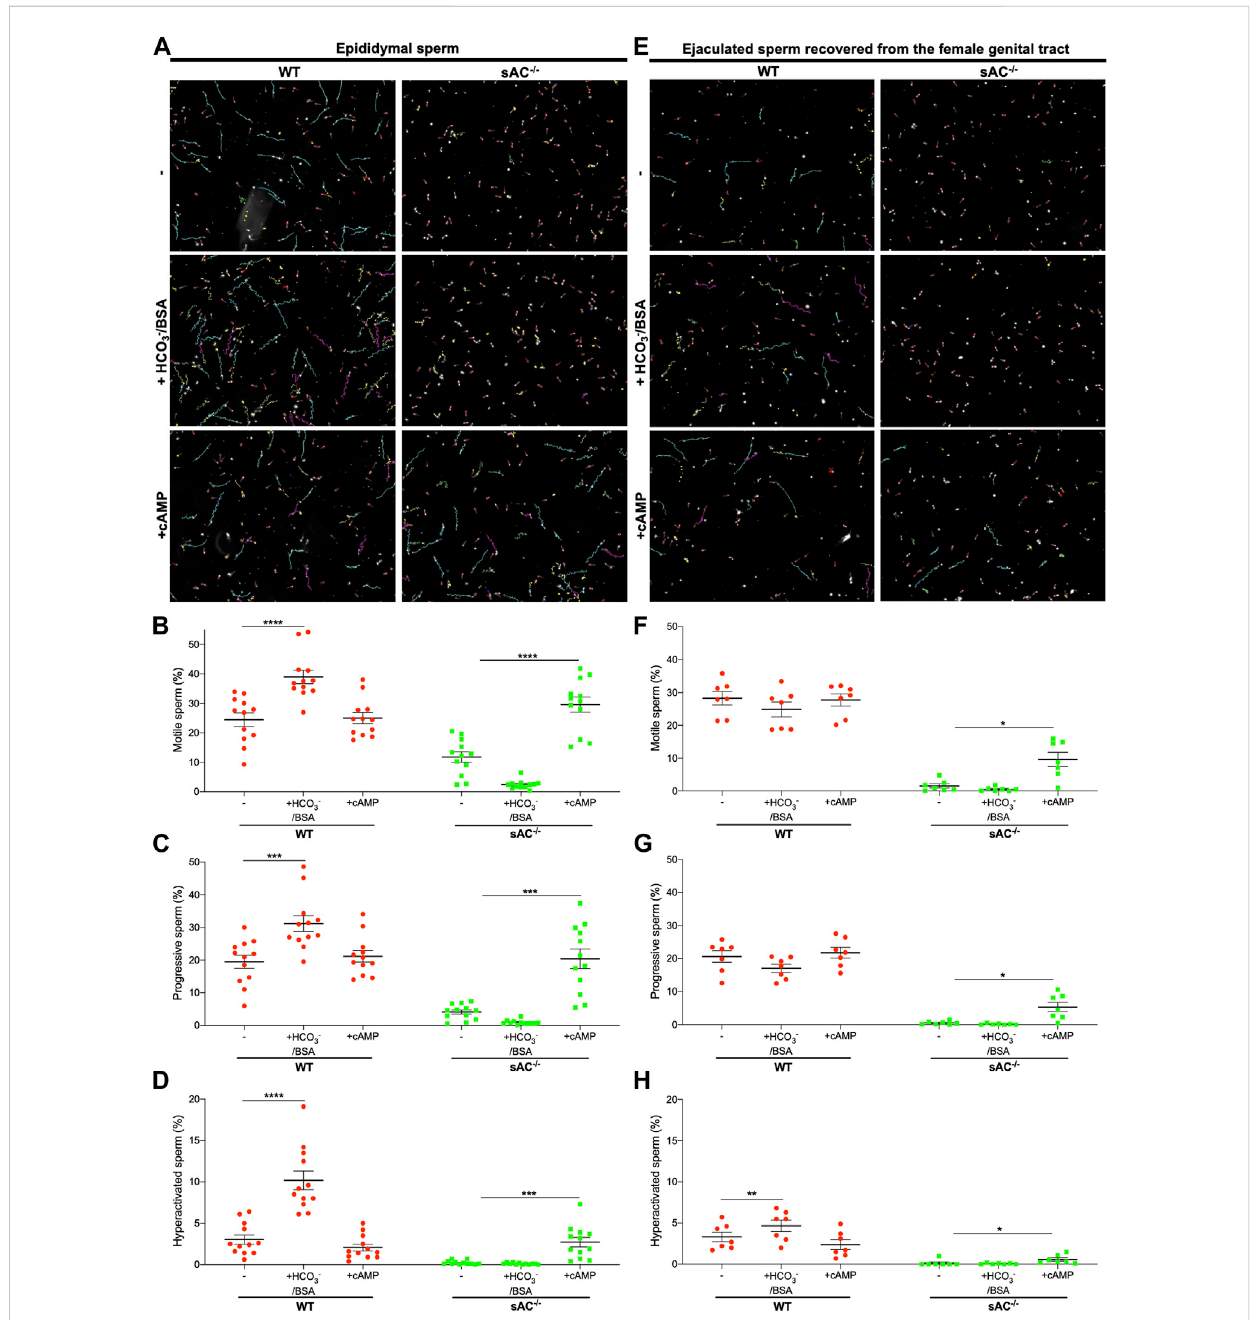
FIGURE 2 Epididymal and ejaculated WT (red circles) and sAC − / − (green squares) sperm incubated in the absence ( − ) or presence of 20 mM HCO 3 − and 5 mg/ mL BSA (+HCO 3 − /BSA) or 0.5 mM 8Br-cAMP and 0.5 μ M IBMX (+cAMP) for 20 min (A,E) Representative images with motility tracks of the CASA obtained with IVOSII Hamilton Thorne. Track´s color code: motile (green), progressive (turquoise), hyperactivated (pink), static (red), not counted (yellow). Bar graphs show percent total motility (B,F) , progressive motility (C,G) and hyperactivation (D,H) with the individual values for each experiment indicated. Data shown as mean ± SEM, representative of at least 7 independent experiments. More than 500 sperm in at least 5 fi elds were analyzed. Hyperactivated sperm are de fi ned by: VCL ≥ 271 μ m/s, LIN < 50%, and ALH ≥ 5 μ